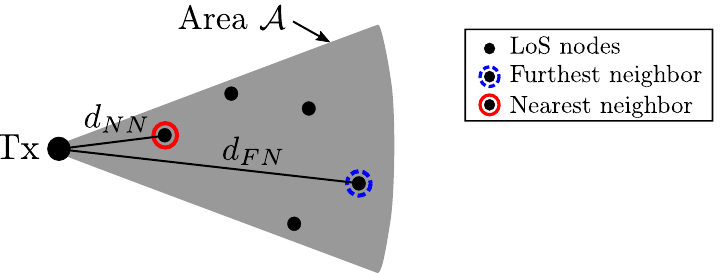
Figure 2. Hop distances of two routing strategies: furthest neighbor (FN) and nearest neighbor